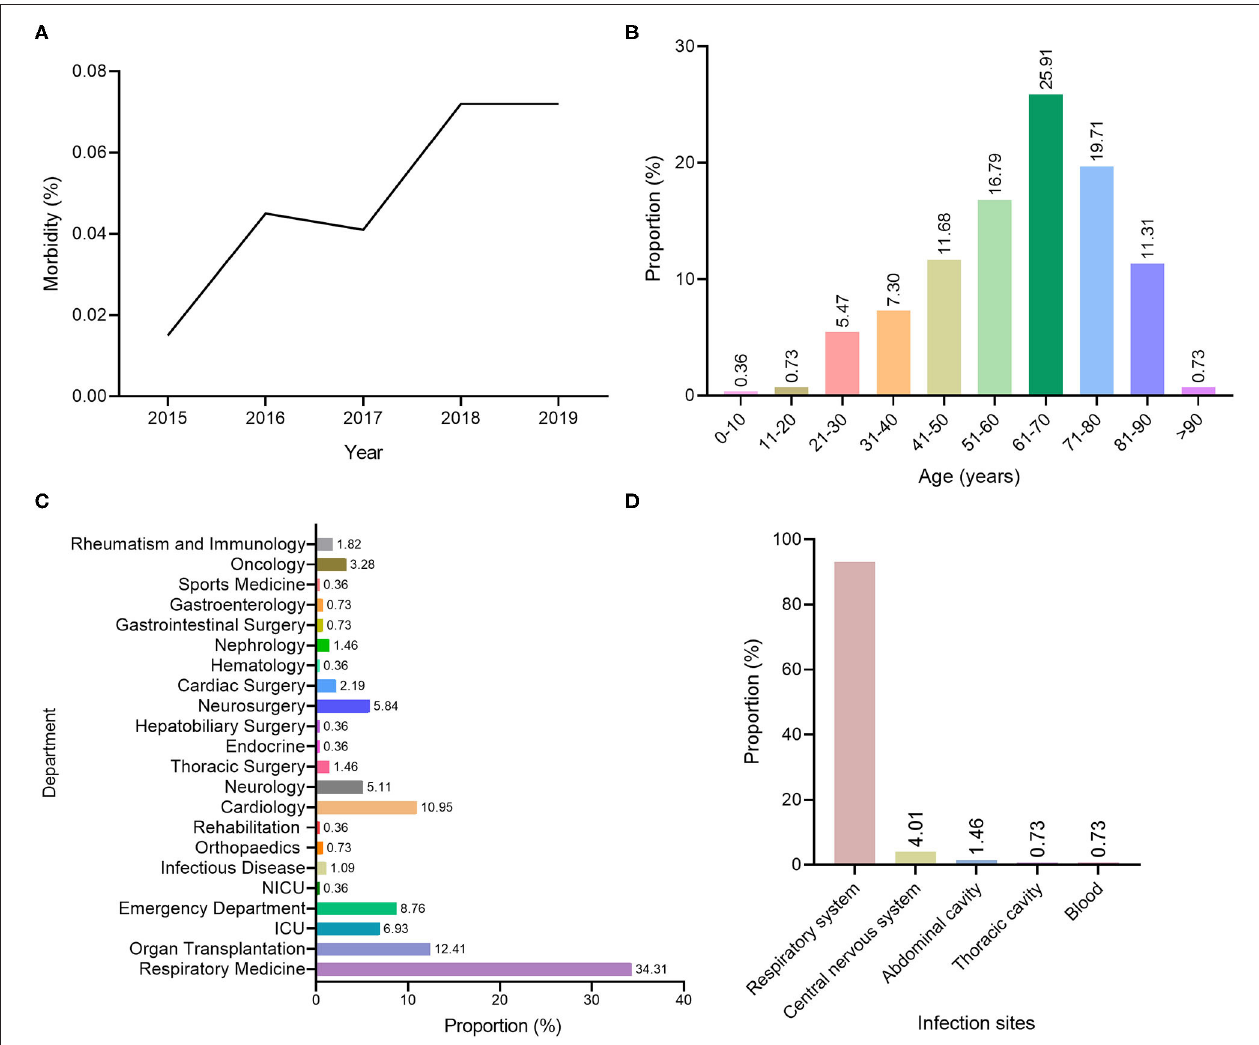
FIGURE 1 | Distribution of selected characteristics of deep fungal infections. (A) Annual distribution of the rate of deep fungal infections. (B) Distribution of patients with deep fungal infections in different age groups. (C) Distribution diagram of departments with patients with deep fungal infections. (D) Distribution of deep fungal infection